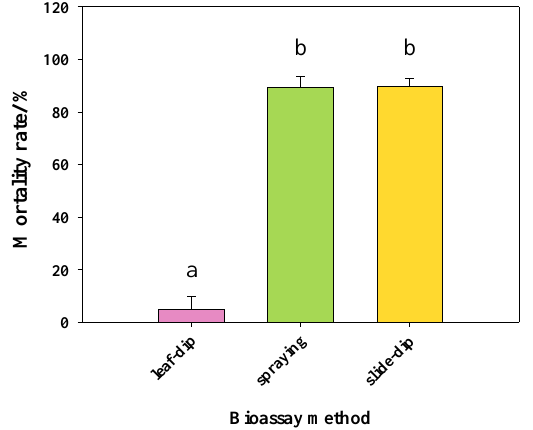
Figure 1. The mortality rates after 24 h of Tetranychus pueraricola under 6.67 g/L GC16 with different bioassay methods. Data are expressed as mean ± SE. Different lowercase letters represent significant differences at p < 0.05 based on a one-way ANOVA with Tukey’s HSD test.